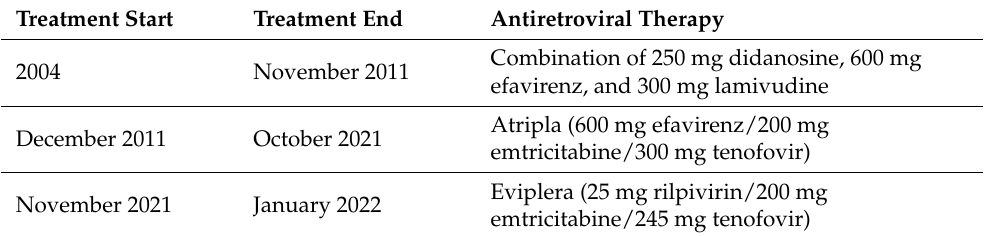
Table 2. Antiretroviral treatment taken by the patient from 2004 to January 2022.